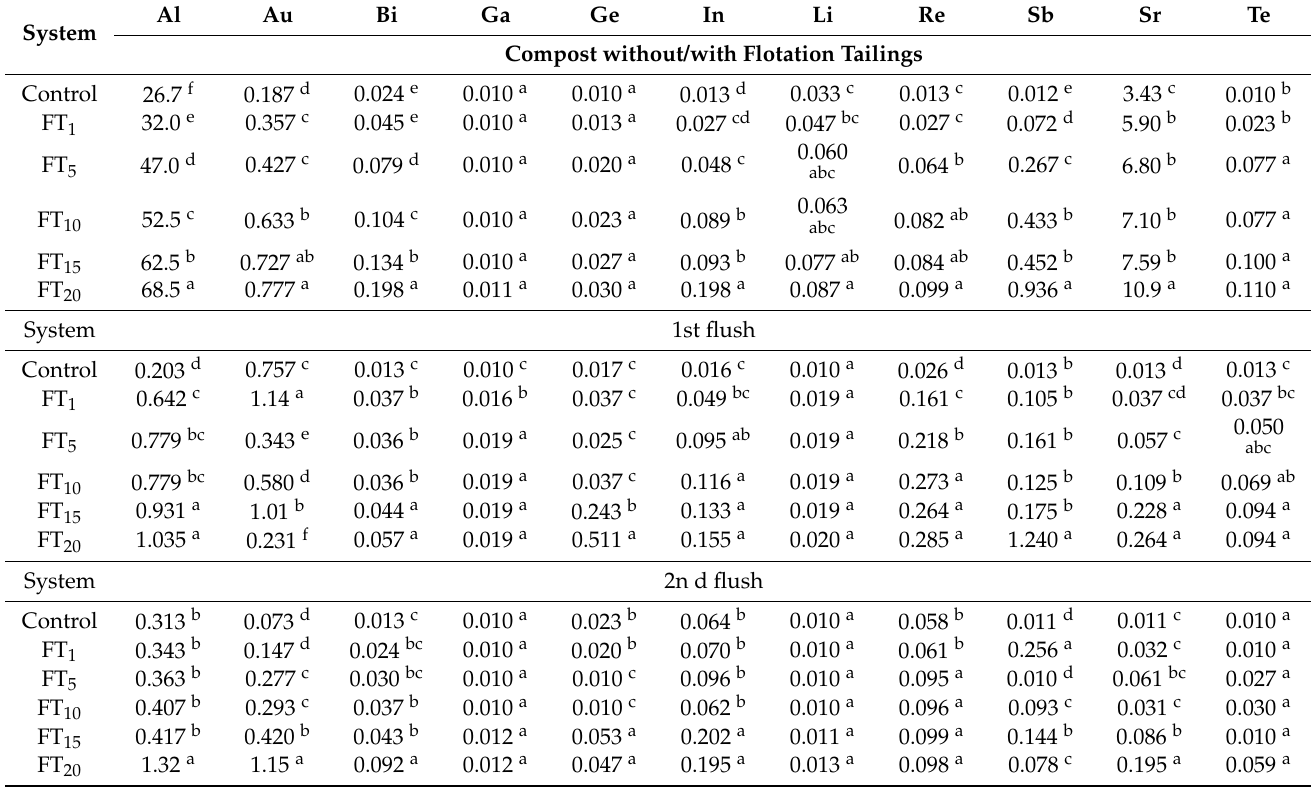
Table 7. Content of nutritionally non-essential elements [mg kg − 1 dry weight] in compost with flotation tailings before the experiment and fruit bodies from particular